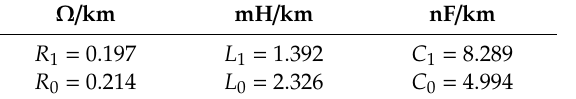
Table 1. Positive and zero sequence parameters.